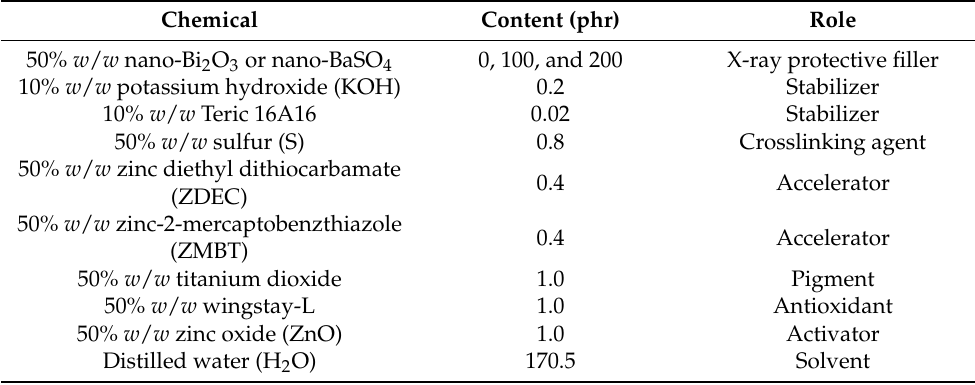
Table 1. Material formulations of SVNRL nanocomposites and their chemical names, content, and